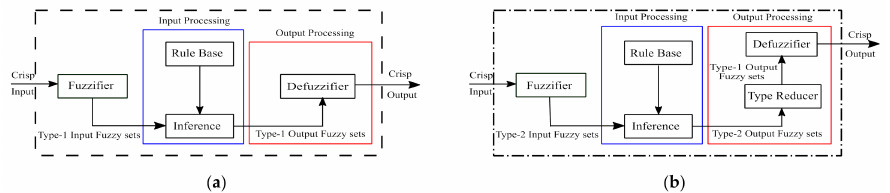
Figure 4. Structures of fuzzy logic control: ( a ) type-1 fuzzy logic controller (T1-FLC); ( b ) interval type-2 fuzzy logic controller (IT2-FLC).